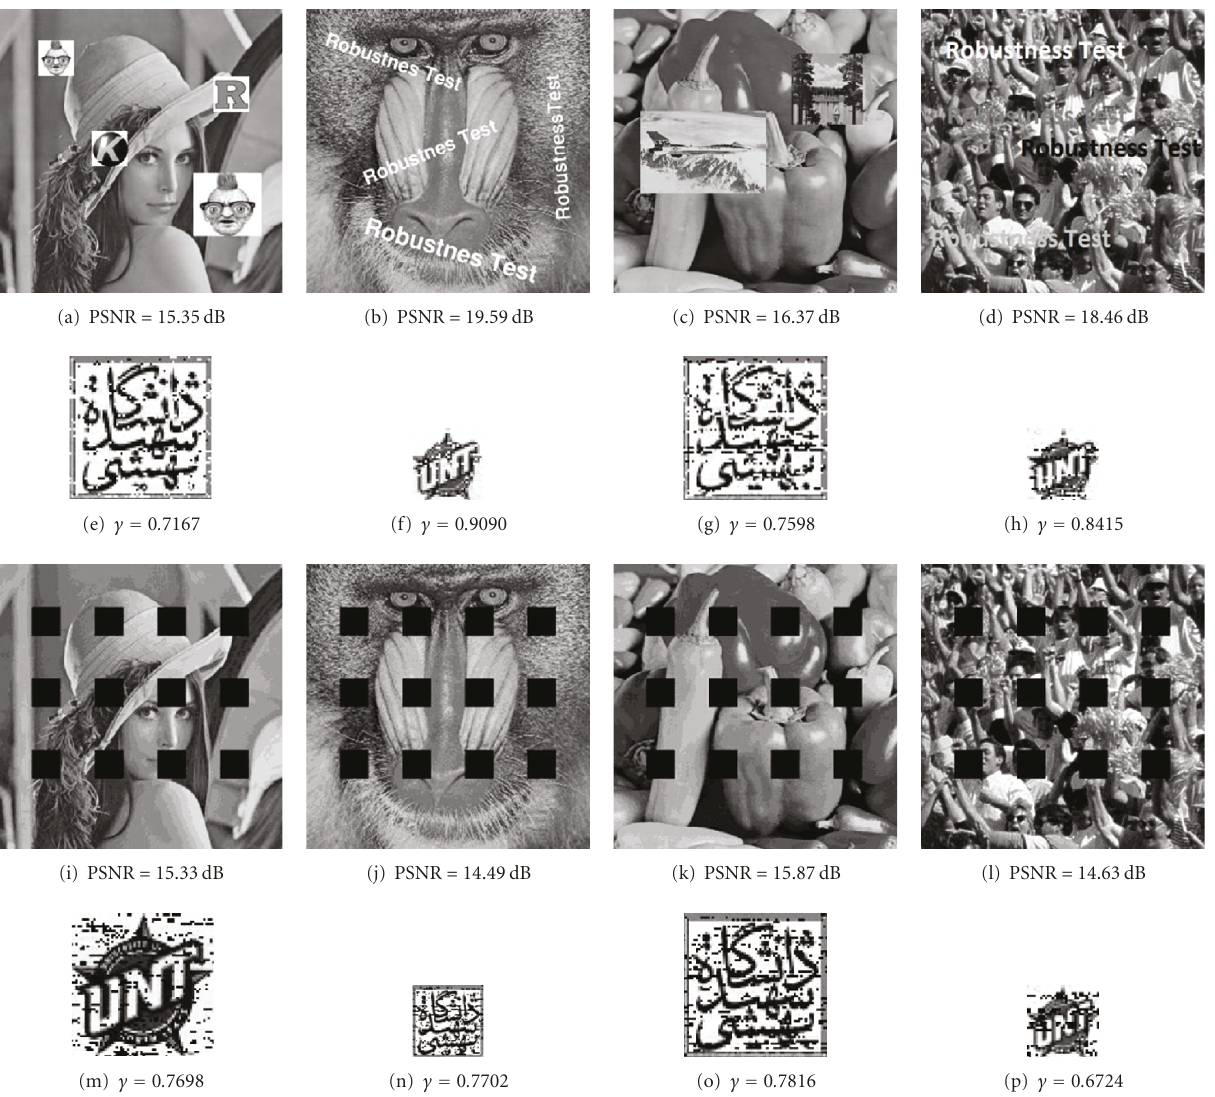
Figure 27: (a)–(d) The watermarked Lena, Baboon, Peppers and Crowd images after tampering, respectively. (e)–(h) The extracted watermarks from (a)–(d), respectively. (i)–(l) The watermarked Lena, Baboon, Peppers and Crowd images after data blocks removal, respectively. (m)–(p) The extracted watermarks from (i)–(l),